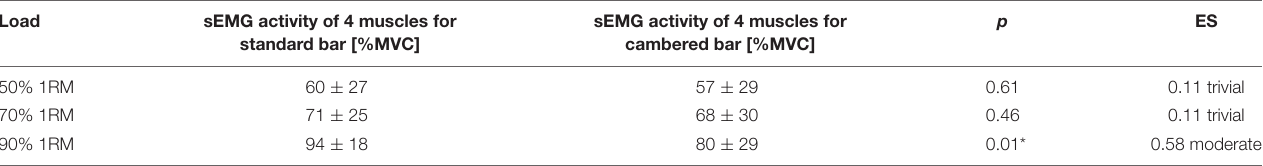
TABLE 3 | The result of main differences in sEMG activity of muscles between used